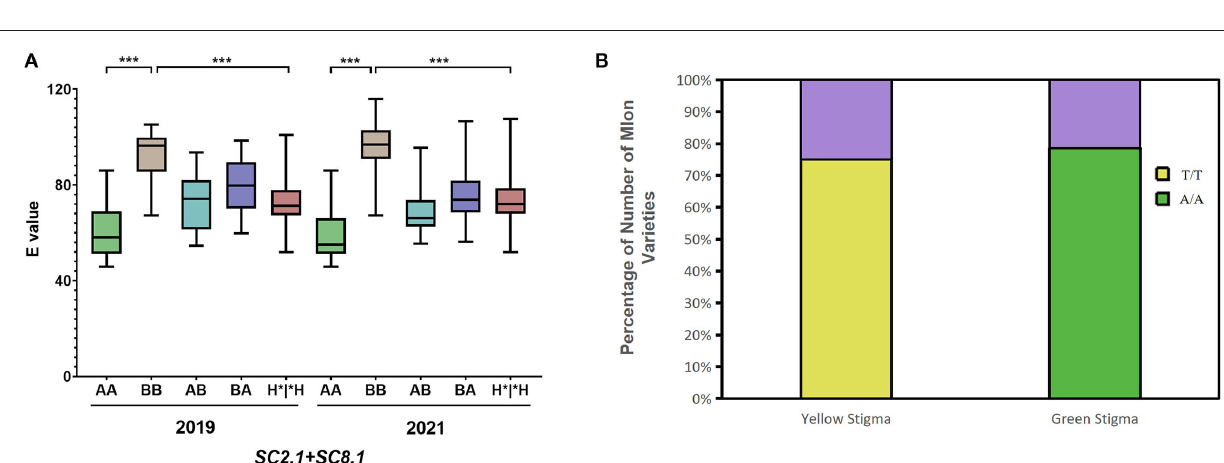
FIGURE 6 | Genotype analysis of quantitative trait locus (QTL) and candidate gene ( MELO03C003165 ). (A) The combined genotype and phenotype of SC2.1 + SC8.1 in F 2 individuals were recorded in 2019 and 2021. In the horizontal coordinates, the former genotype belongs to SC2.1 , the latter genotype belongs to SC8.1 , and H*|*H represents the genotype containing H. (B) Relationship between genotype and stigma color of the MELO03C003165 alleles in 110 melon varieties. The purple color shows the proportion of genotype and phenotype inconsistencies, Yellow and green show the proportion of genotype and phenotype